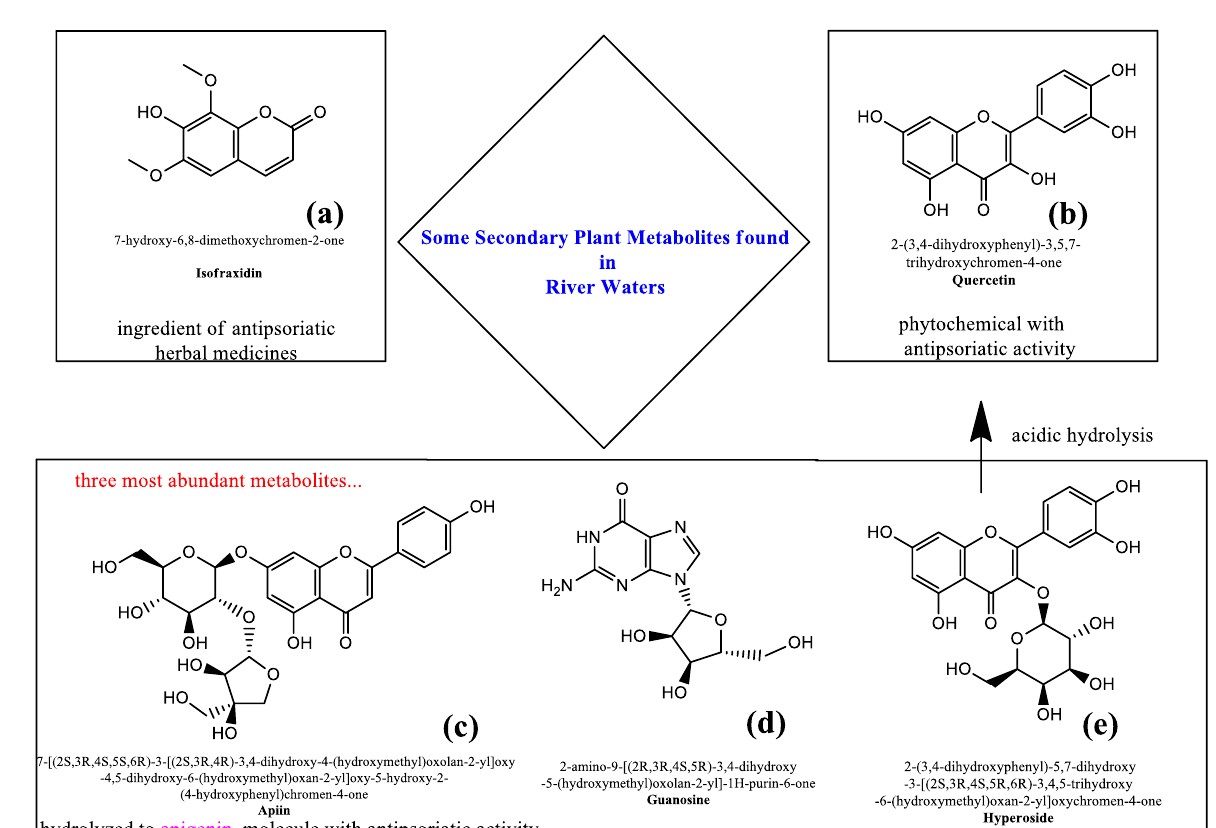
Figure 1. Chemical structures of some of the plant metabolites ( a – e ) detected in river waters. Note how the most abundant apiin ( c ), guanosine ( d ) and hyperoside ( e ) subjected to the in silico analysis of the current work are shown in the rectangular box, while isofraxidin ( a ), contained in an antipsoriatic treatment, and quercetin ( b ), with known antipsoriatic activity and in turn obtained after acidic hydrolysis of hyperoside, are represented in the upper part of the figure.